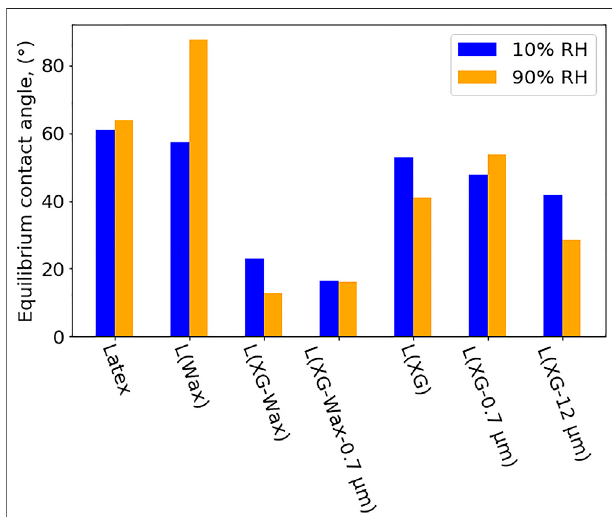
FIGURE 8 | Measured contact angle for a range of samples at 20 ° C and two RH conditions. These values were obtained after 10 s of